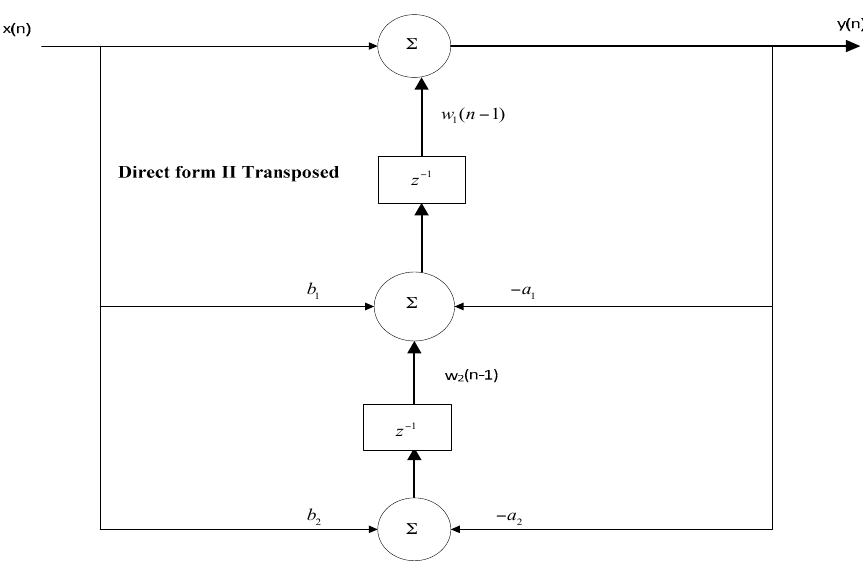
Figure 5. Block diagram of Biquade Direct Form Transposed-II.